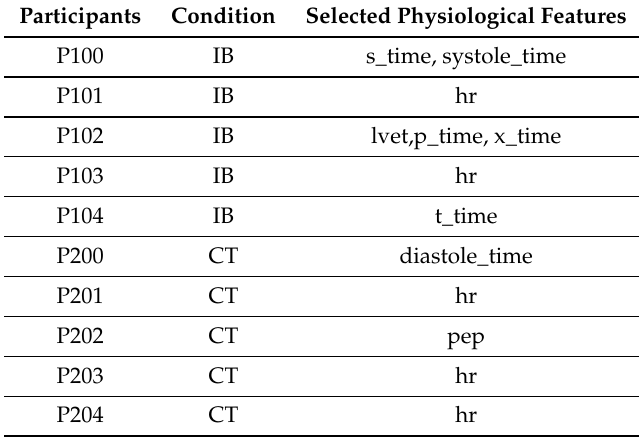
Table 1. Most frequently selected physiological features for 10 defusers, 5 each from the Ice Breaker (IB) and Control (CT) conditions, respectively, during the “bomb defusion” task. The features are labeled